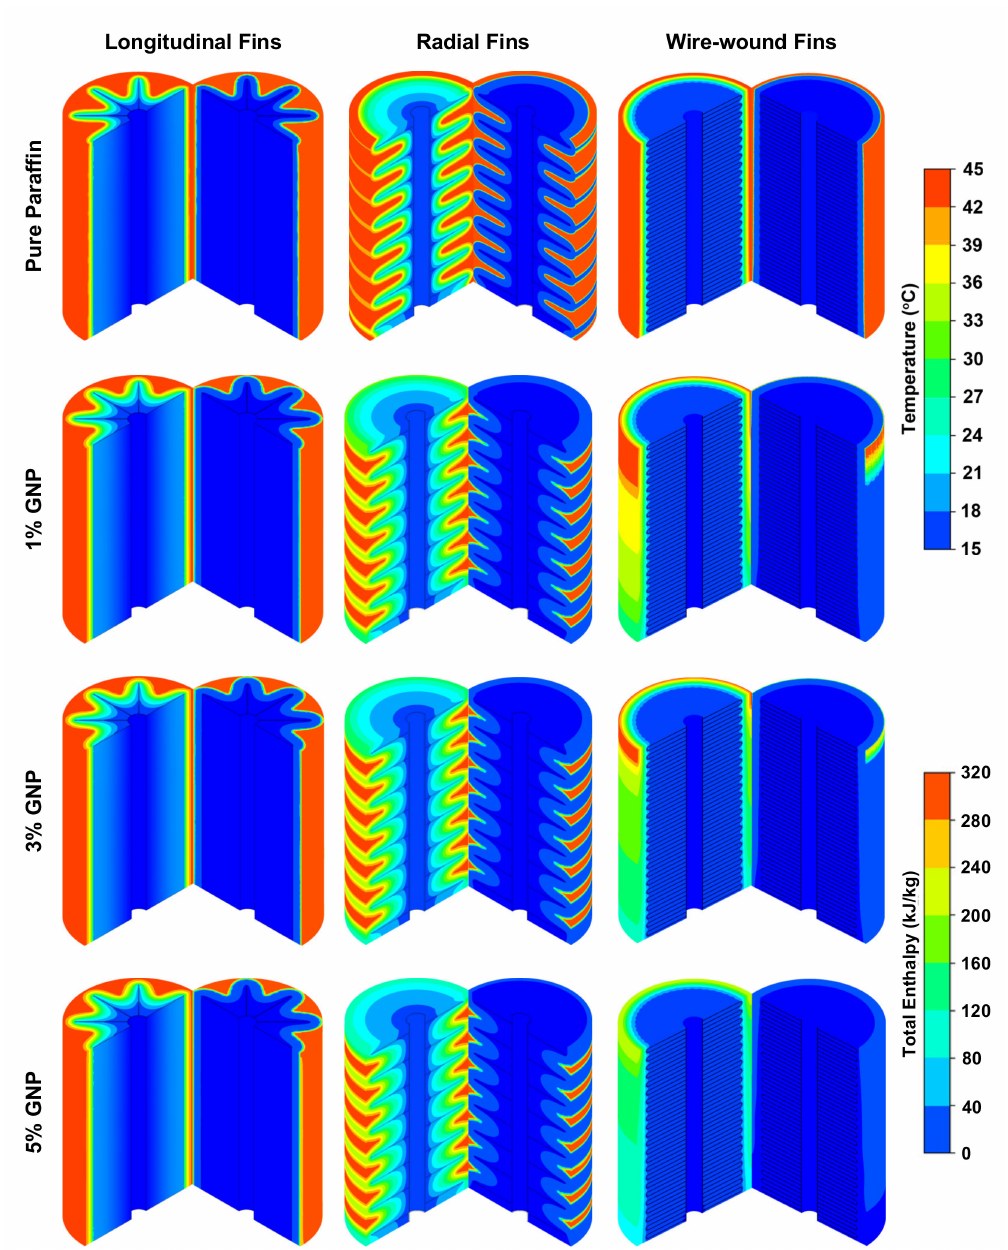
Figure 6. Temperature ( left ) and enthalpy ( right ) contours of paraffin and nano-PCMs with three varied volume fractions in longitudinal, radial and wire-wound fins configurations while discharging for 1